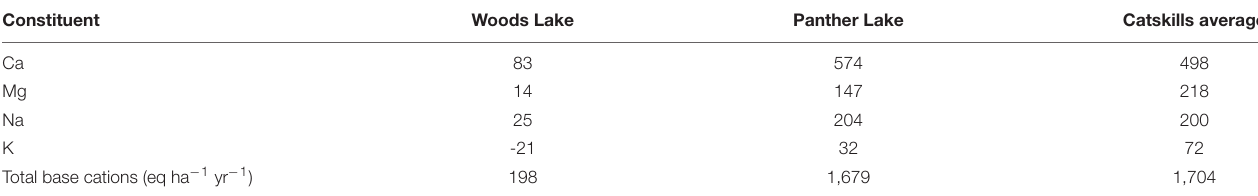
TABLE 6 | Average net geochemical release rates for two watersheds in the Adirondacks (April et al., 1986) and for the watersheds in this study. Constituent Woods